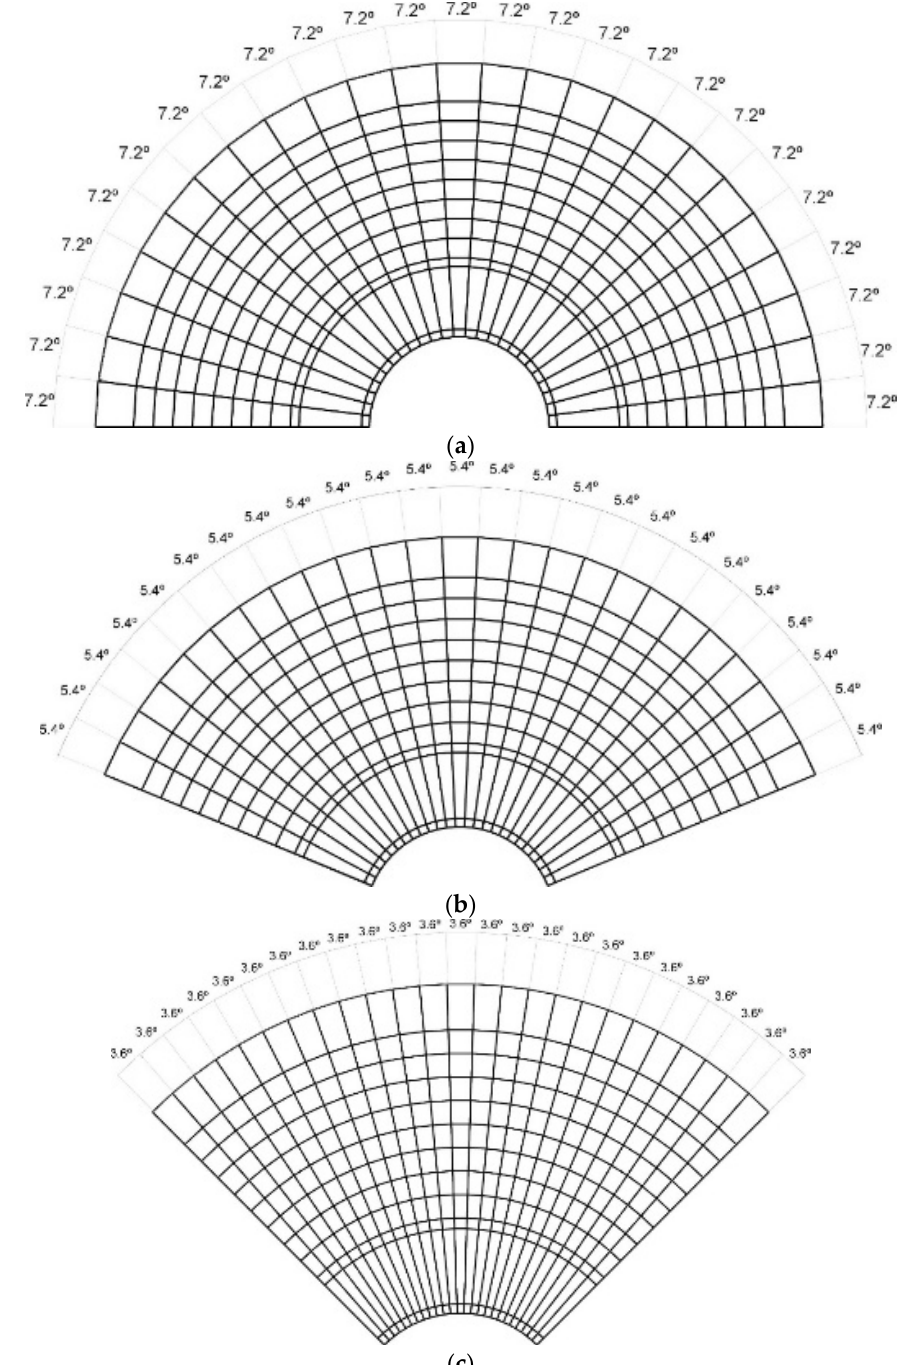
Figure 3. Scheme of the auditorium and details of the opening angle of the DSF system. ( a ) Case A, ( b ) Case B, and ( c ) Case C. Three-dimensional top view.